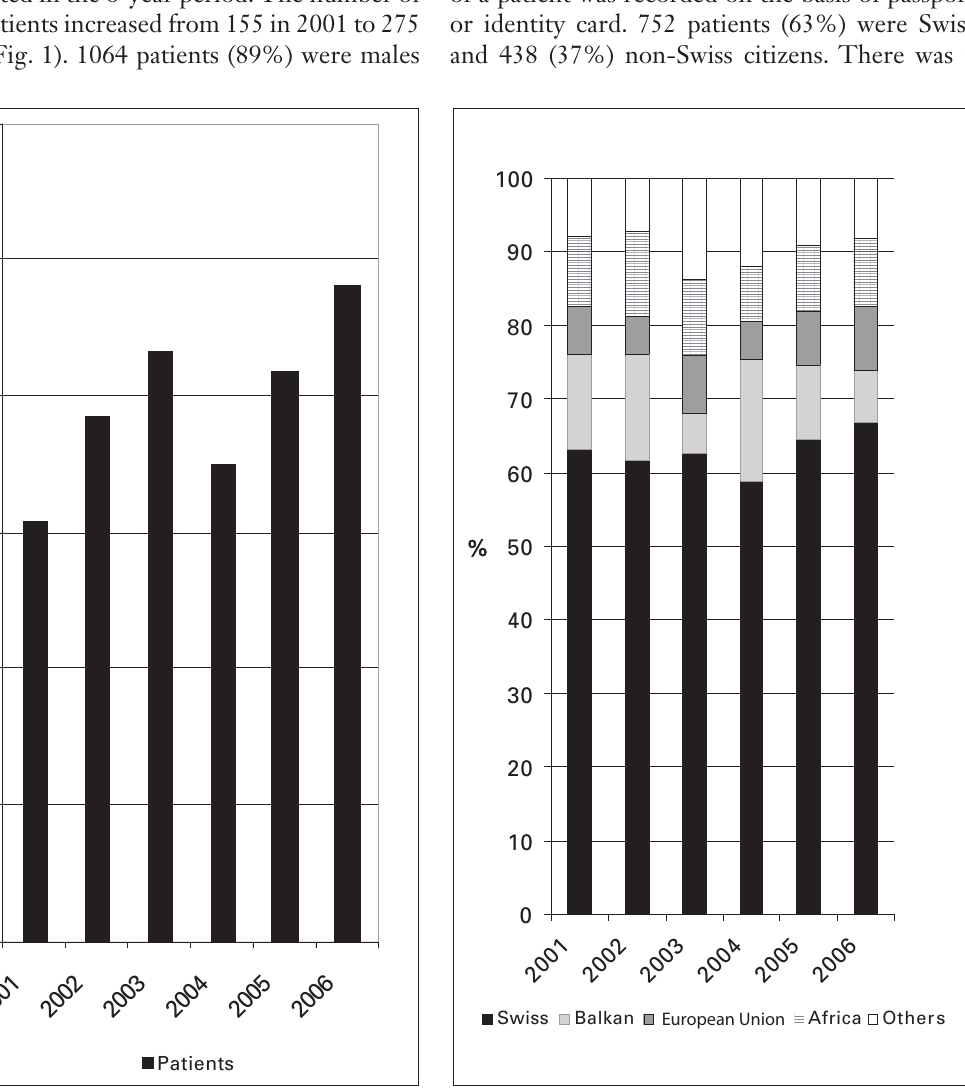
Figure 1 Number of patients seen per year.